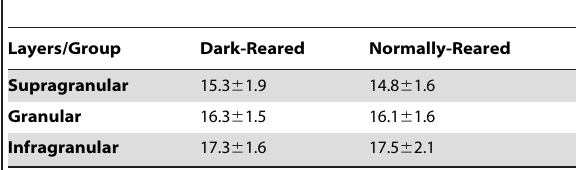
Table 5. Chronic visual deprivation does not affect the numerical densities of ER a -positive cells across cortical layers of V1.